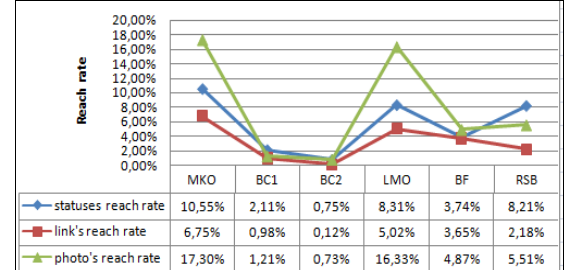
Figure.6. Number of fans of each Facebook page used in this experiment